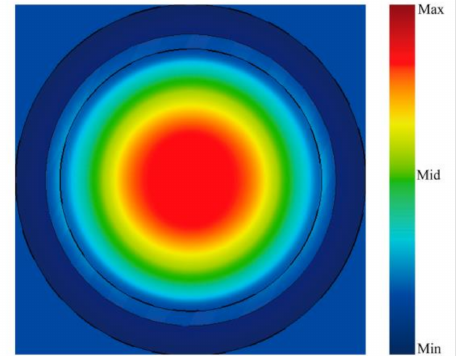
Figure 4. Electric field distribution at the output port.